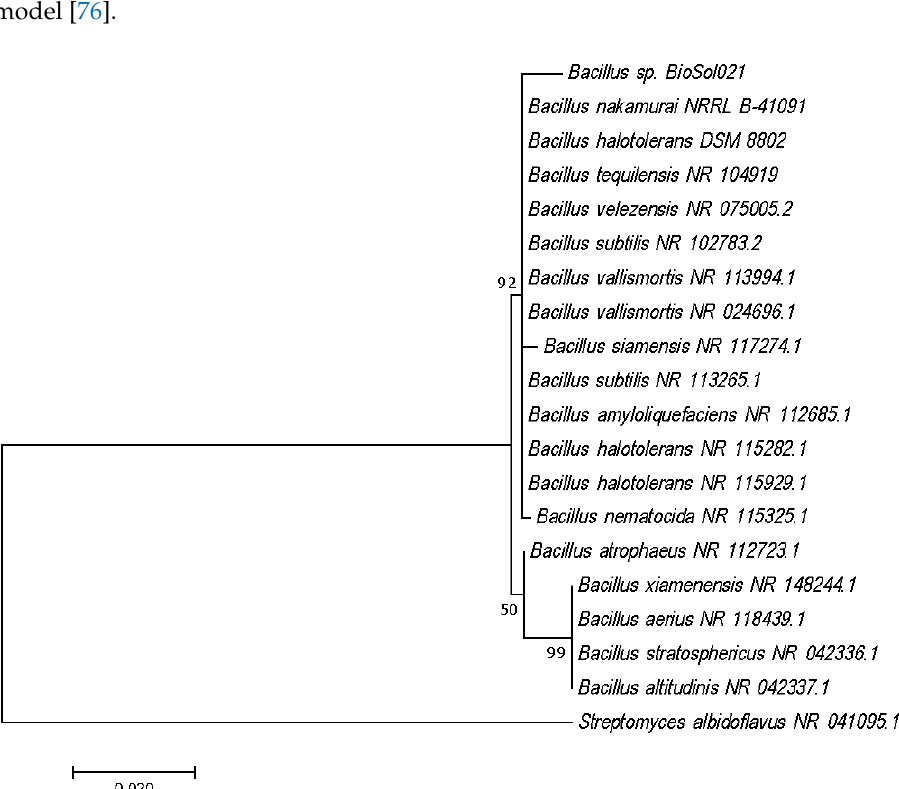
Figure 1. Molecular phylogenetic analysis of the Bacillus sp. strain BioSol021 16S rRNA gene sequence by the maximum likelihood method.